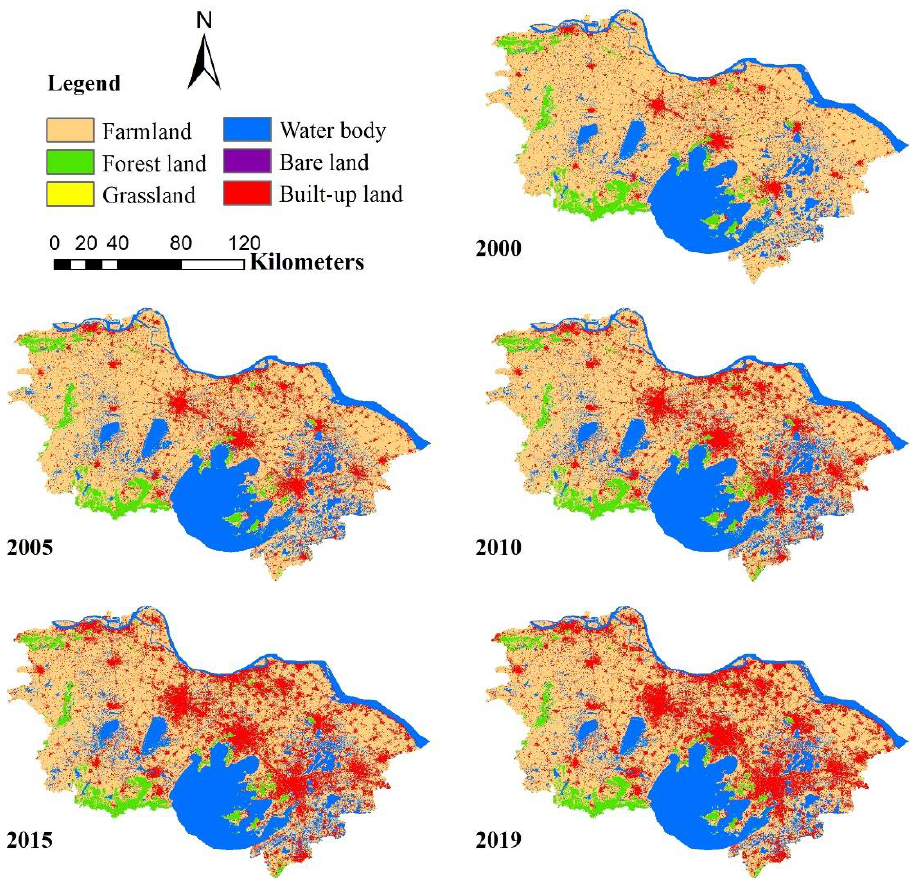
Figure 3. Spatial distribution of land use in the study area from 2000 to 2019. Table 2. Area and land use change dynamics in SCBJ from 2000 to 2019.